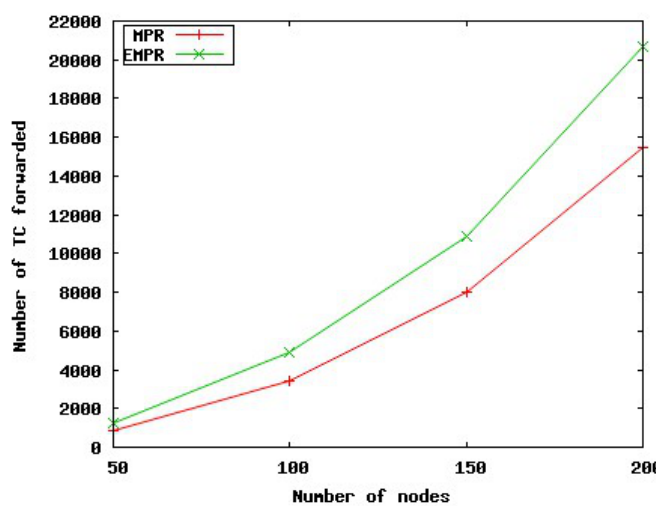
Figure 4. Number of TCs forwarded in the